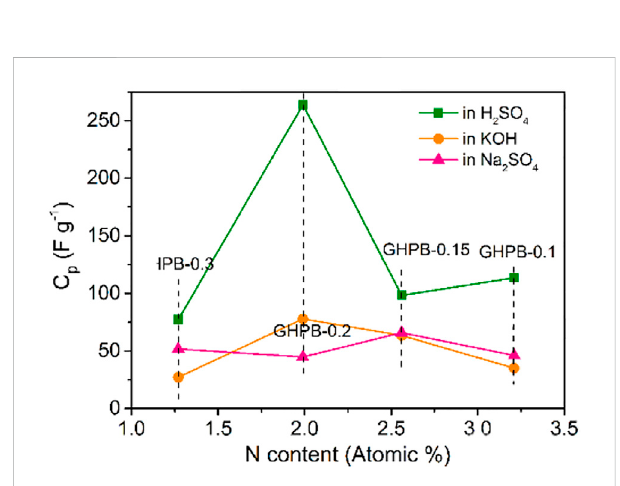
Relationship between the speci fi c capacitance and N content (Yao et al.,